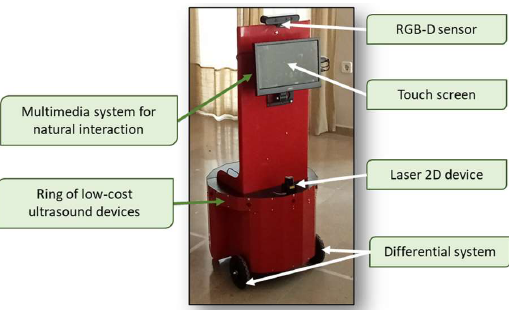
Figure 1. JUNO robotic platform. The radius of the widest part of the robot is 0.25 m and the height is around 1.60 m.